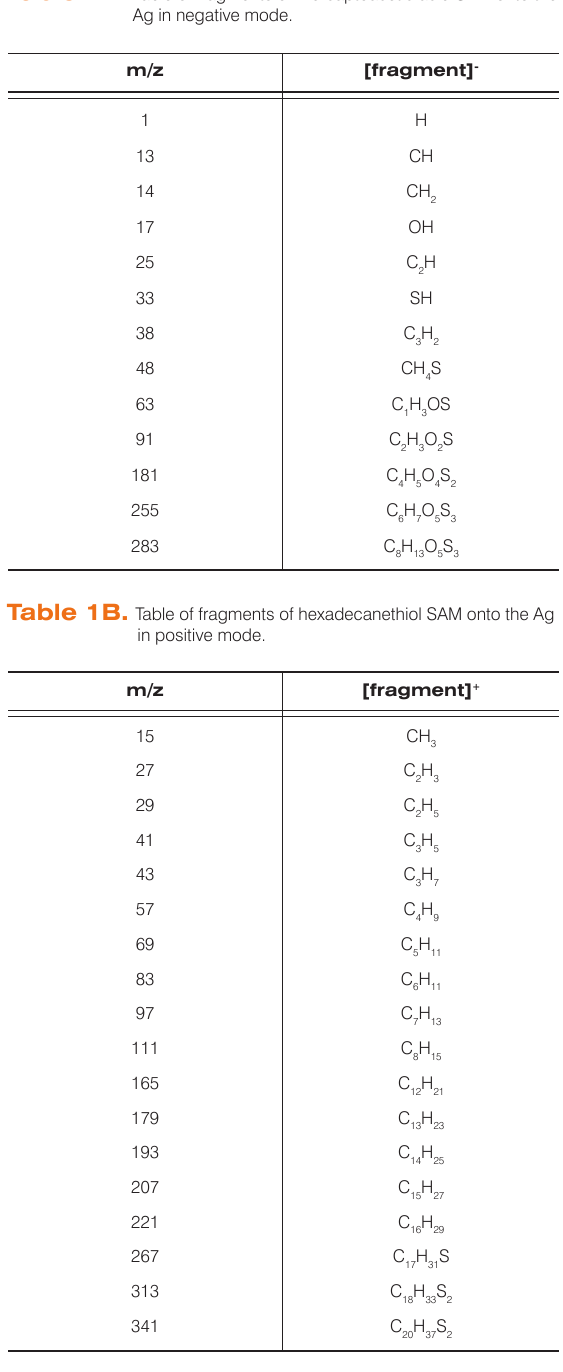
Table 1A. Table of fragments of mercaptoacetic acid SAM onto the Ag in negative mode.